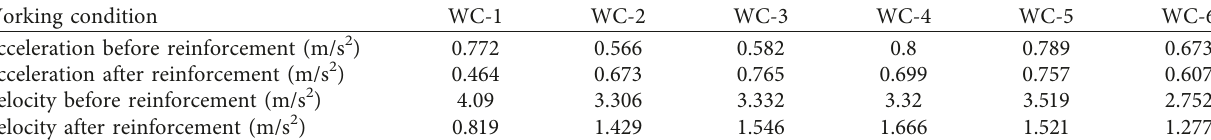
Table 5: Peak value of acceleration and velocity in the X direction at measuring point 5.